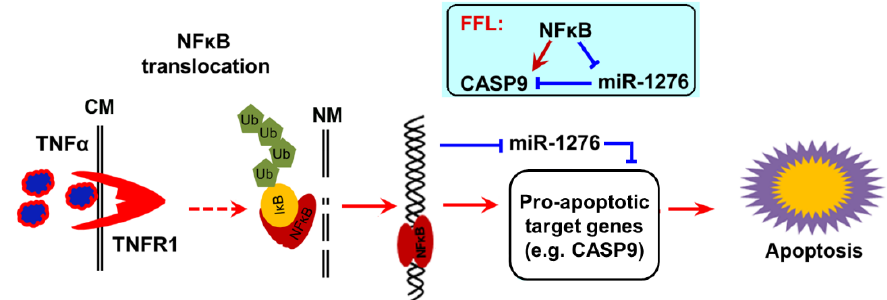
Figure 10. The scheme of NF- κ B pro-apoptotic function. After activation by TNF α , NF- κ B enters the cell nucleus, where it directly upregulates a pro-apoptotic target gene CASP9 and directly downregulates a target miRNA miR1276. CASP9 is a target gene of miR1276. A NF- κ B-mediated feed-forward loop (FFL) is consequently established (inset). The up-expressions of pro-apoptotic target genes of NF- κ B contributed to NF- κ B-involved apoptosis under certain conditions.